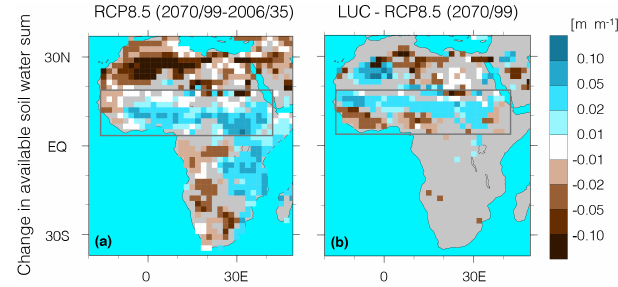
Figure 5. Change in the available soil water towards the end of the century (2071–2100) simulated within RCP8.5 (a) and the am- plification within LUC compared to RCP8.5 (b) at the end of the simulations. Non-significant differences areas are marked